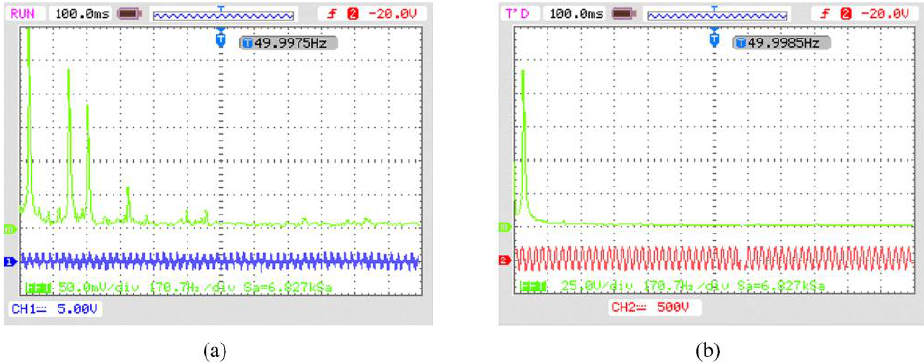
Figure 11. Exemplary results; the firing angle equal to 60°; motor loaded; ( a ) input current and input line-to-line voltage waveforms; ( b ) motor current and motor supply voltage waveforms.